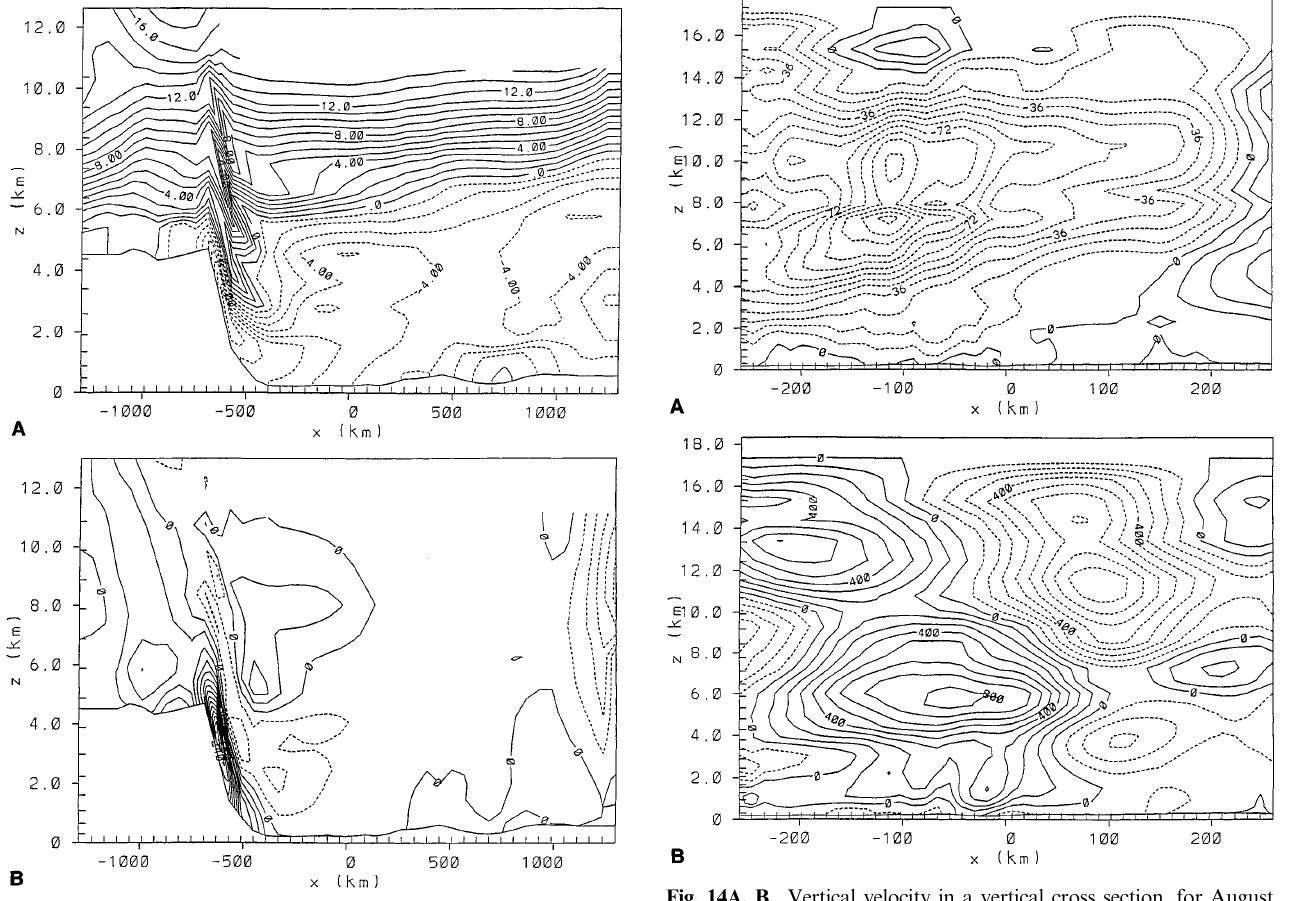
Fig. 13. A Zonal component and B vertical component of the wind field in a vertical cross section, for August 17, 1994, 1800 UTC. Cross section taken at 30 km north of the centre of the domain. Topography outline at the bottom . Dashed lines indicate negative values. Iso lines at every 1 m Æ s ) 1 . Simulation started on August 15, 1994, 12 UTC